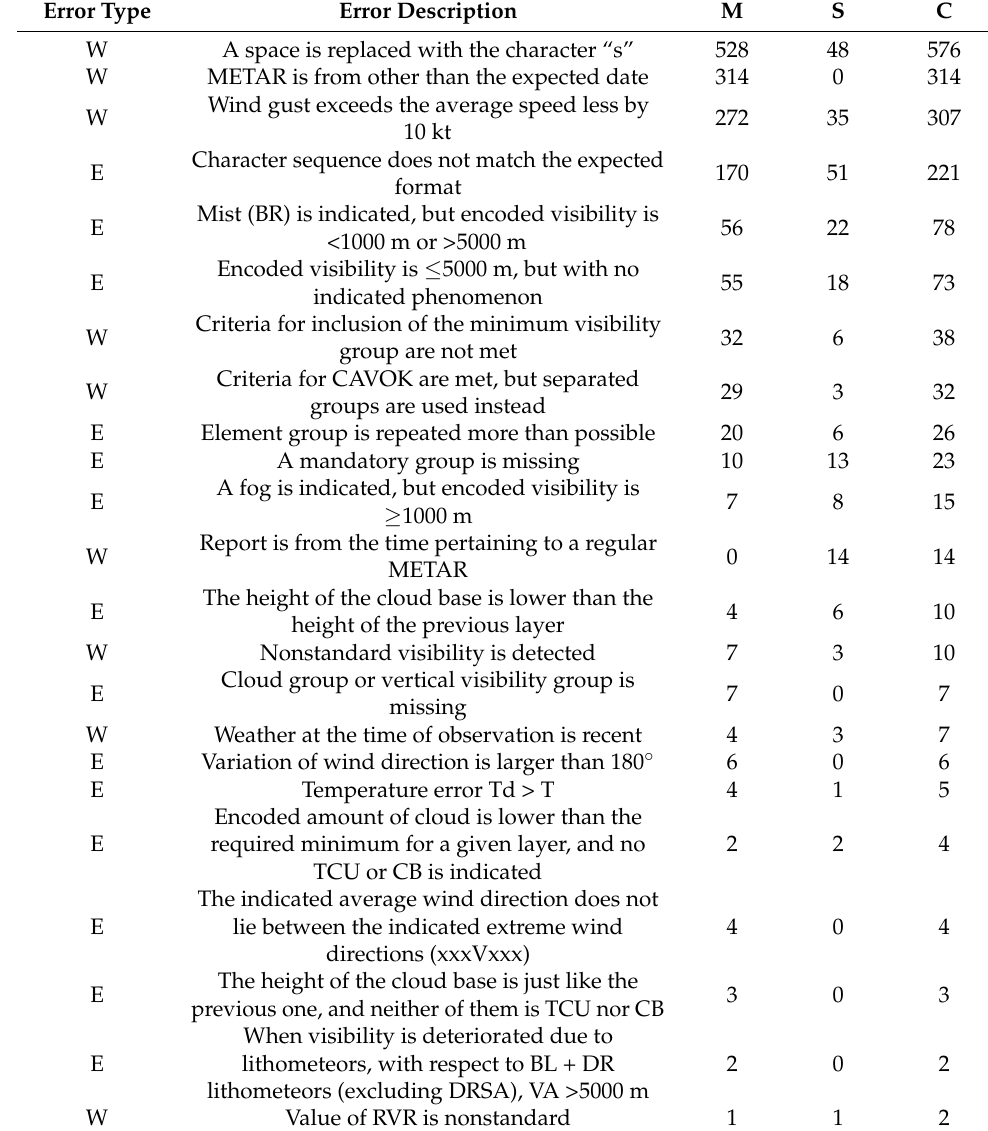
Table 7. Overview of total number of ERROR (E) and WARNING (W) errors at the analyzed stations in the METAR (M), SPECI (S), and METAR + SPECI (C) reports. BR, abbreviation of the French word “brume”; CAVOK, clouds and visibility OK; TCU, towering cumulus; BL, blowing; DR, drifted; DRSA, drifted sand; VA, volcanic ash; RVR, runway visual range. Error Type Error